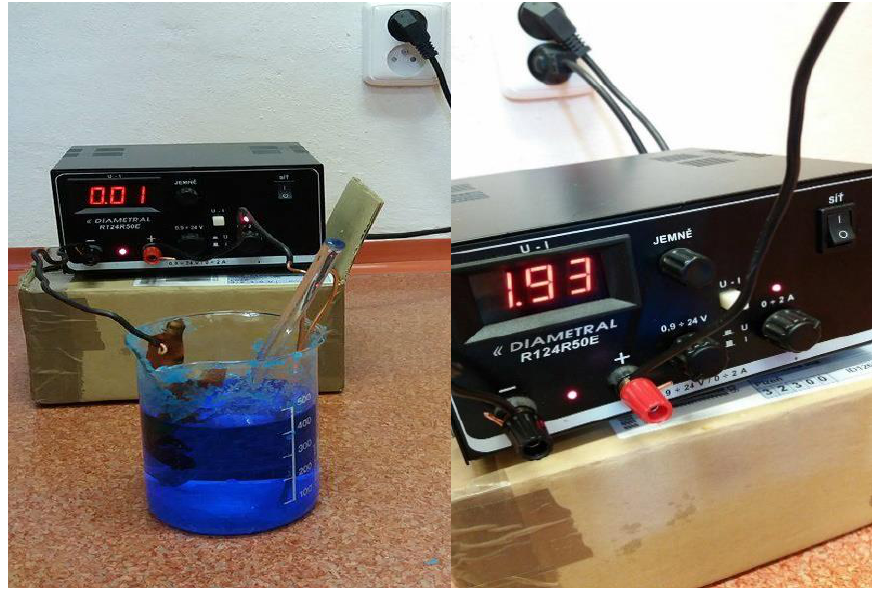
Figure 1. Electroplating process on conductive fabric. Table 1. The design of the experiment for electroplating the textile samples. Sr.